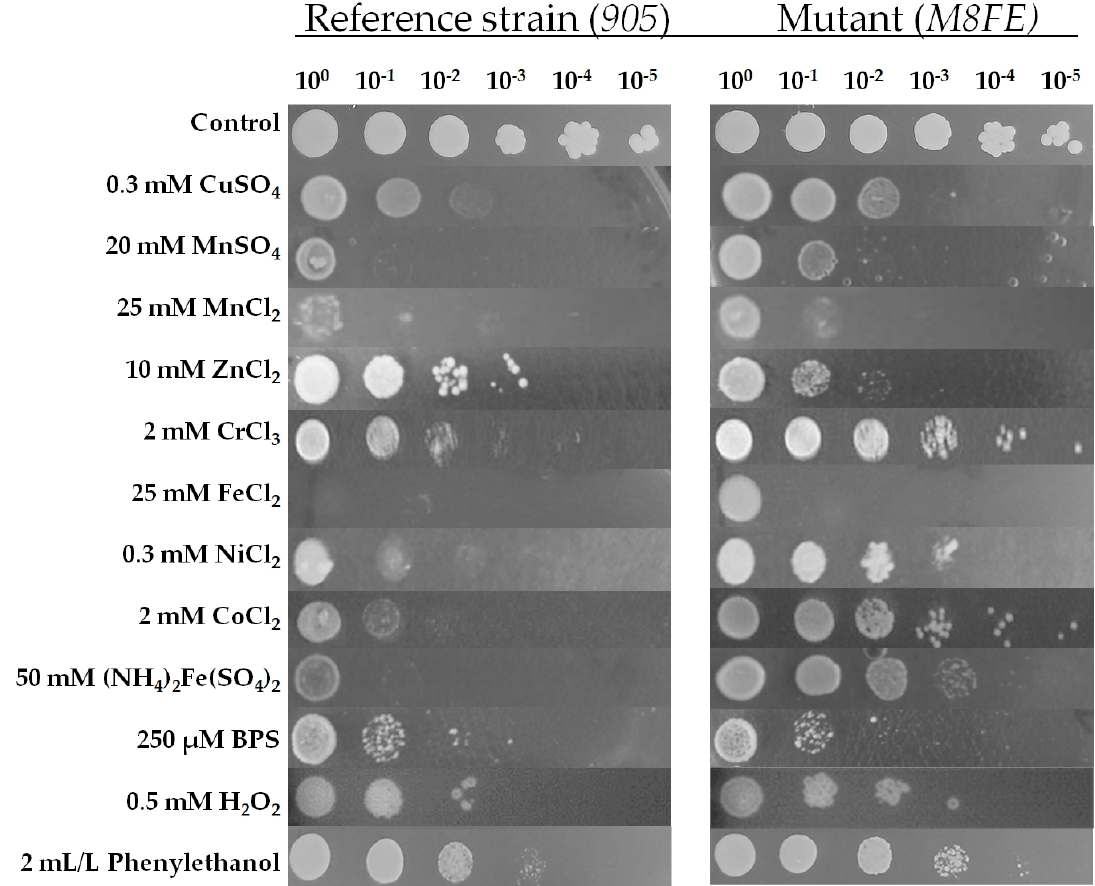
Figure 2. Spot assay profiles of 905 and M8FE under a variety of stress conditions. Dilutions are shown from 10 0 to 10 − 5 , from left to right.